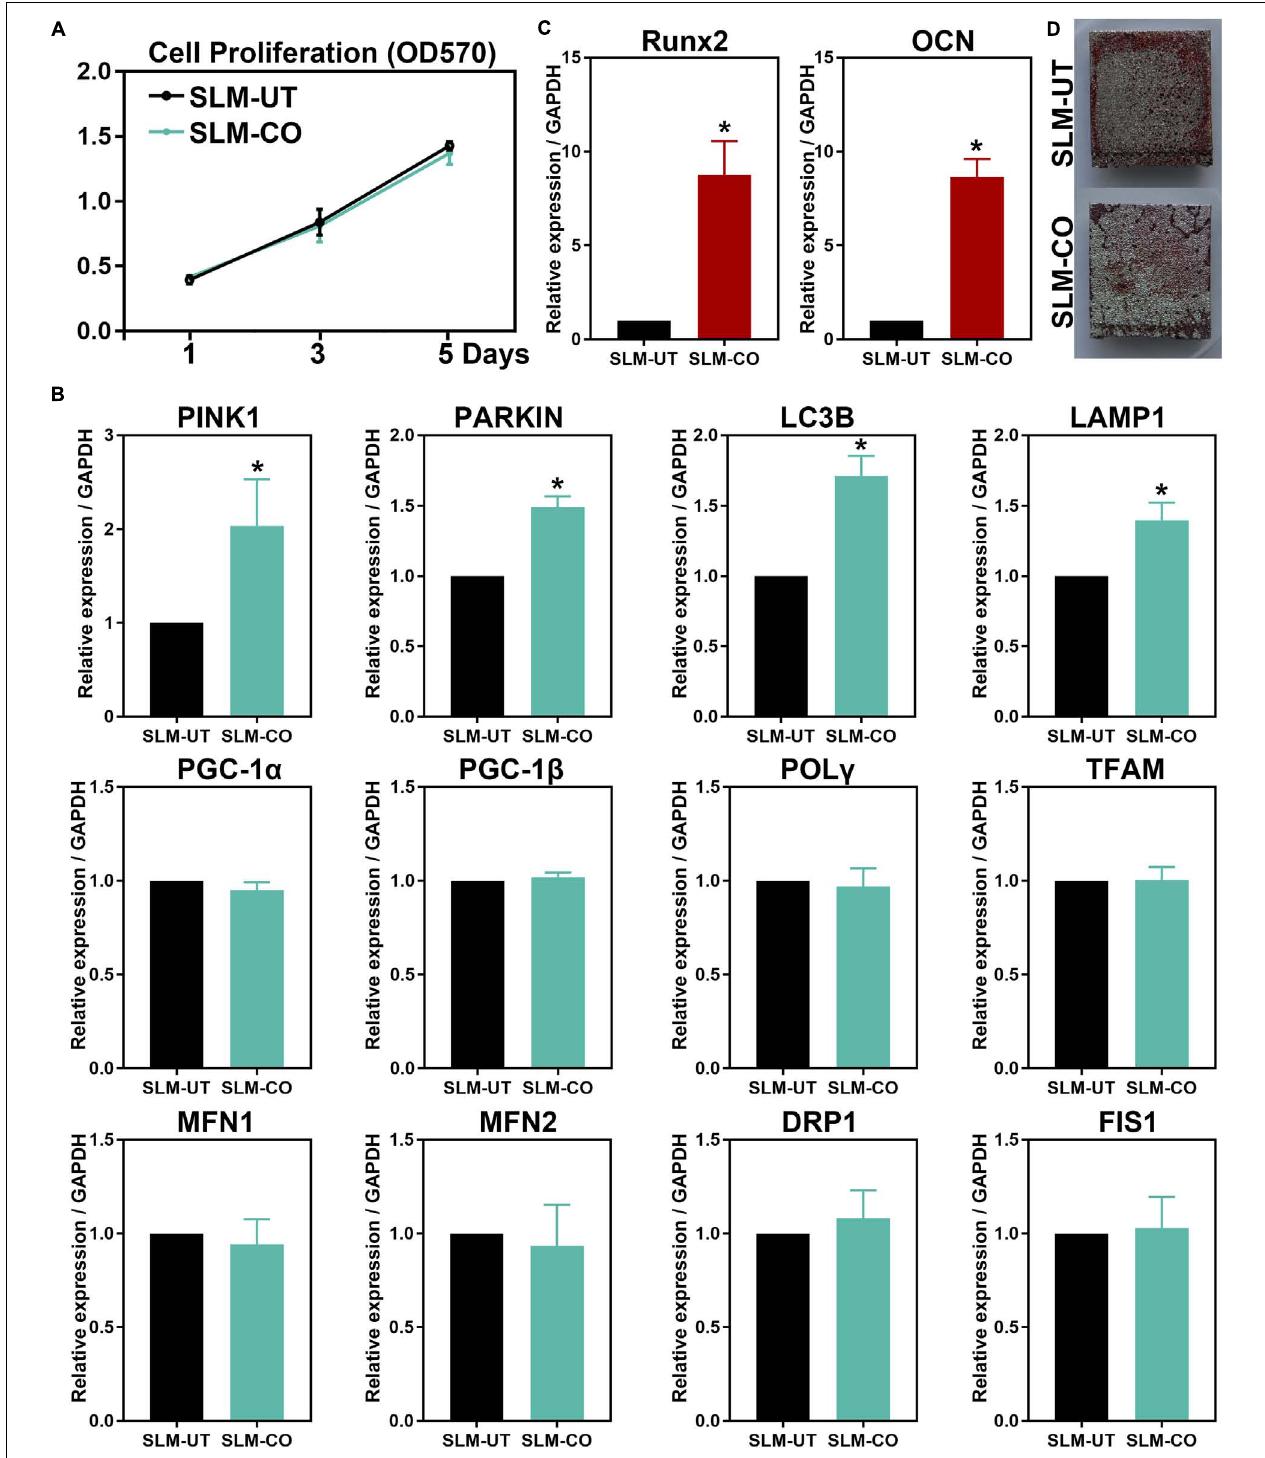
FIGURE 5 | The MG-63 cells proliferation, osteogenesis, and mitochondrial dynamics. (A) No significant difference in cell proliferation between SLM-UT and SLM-CO surfaces. (B) Upregulated relative gene expression of Runx2 and OCN at 14 days. (C) More continuous mineralization nodules of the SLM-CO surface. (D) Upregulated mitophagy related gene expression of the SLM-CO surface (* P < 0.05). No significant difference existed in mitochondrial biogenesis (PGC-1 α , PGC-1 β , POL γ , and TFAM), fission (DRP1 and FIS1), and fusion (MFN1 and MFN2) related gene expression ( P > 0.05).